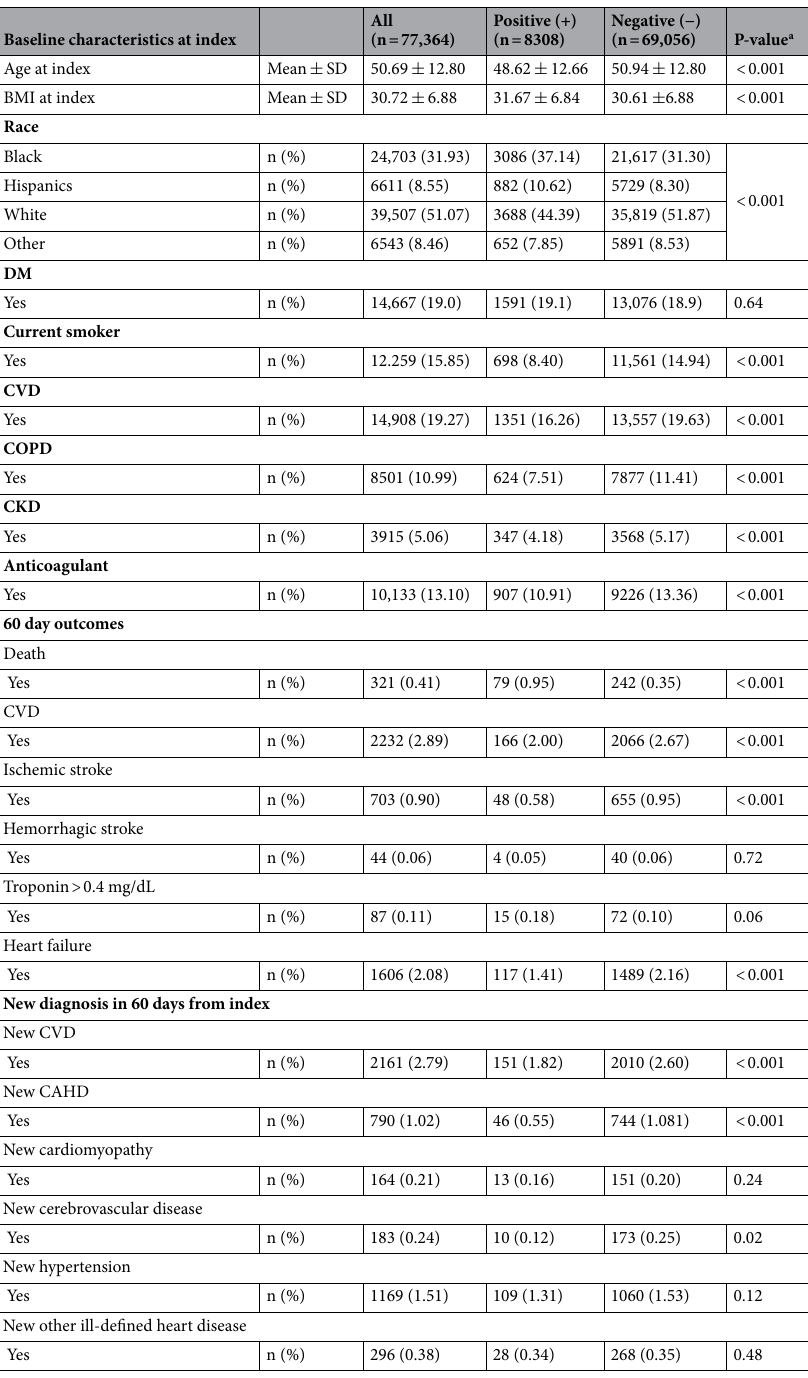
Table 1. Baseline characteristics and 60 day outcomes of veteran women stratified by COVID-19 testing result, positive (+) and negative (−). BMI: Body Mass Index; CAHD : coronary artery heart disease; CVD: cardiovascular disease; DM: Diabetes; CKD: Chronic Kidney Disease; COPD: Chronic Obstructive Pulmonary Disease; HR: Hazard Ratios; CI: Confidence Intervals. a T and chi-squared tests were used for continuous and categorical characteristics,